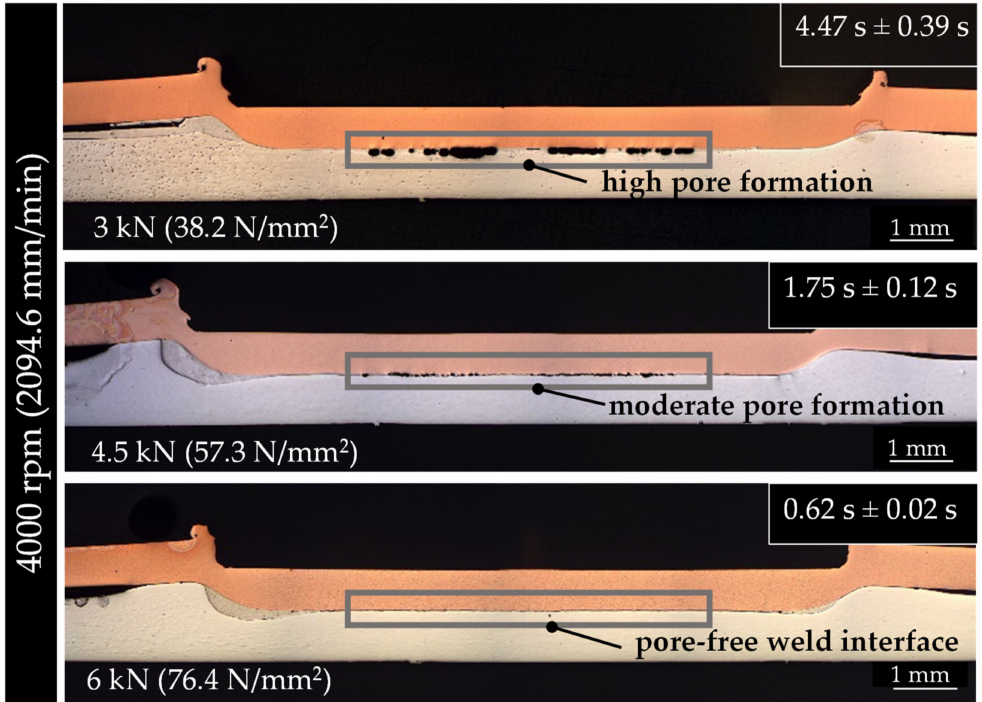
Figure 9. Metallographic micrographs of welds at constant rotational speed and different welding process forces—higher process forces lead to lower process times and pore-free welds—used tool (Ø10